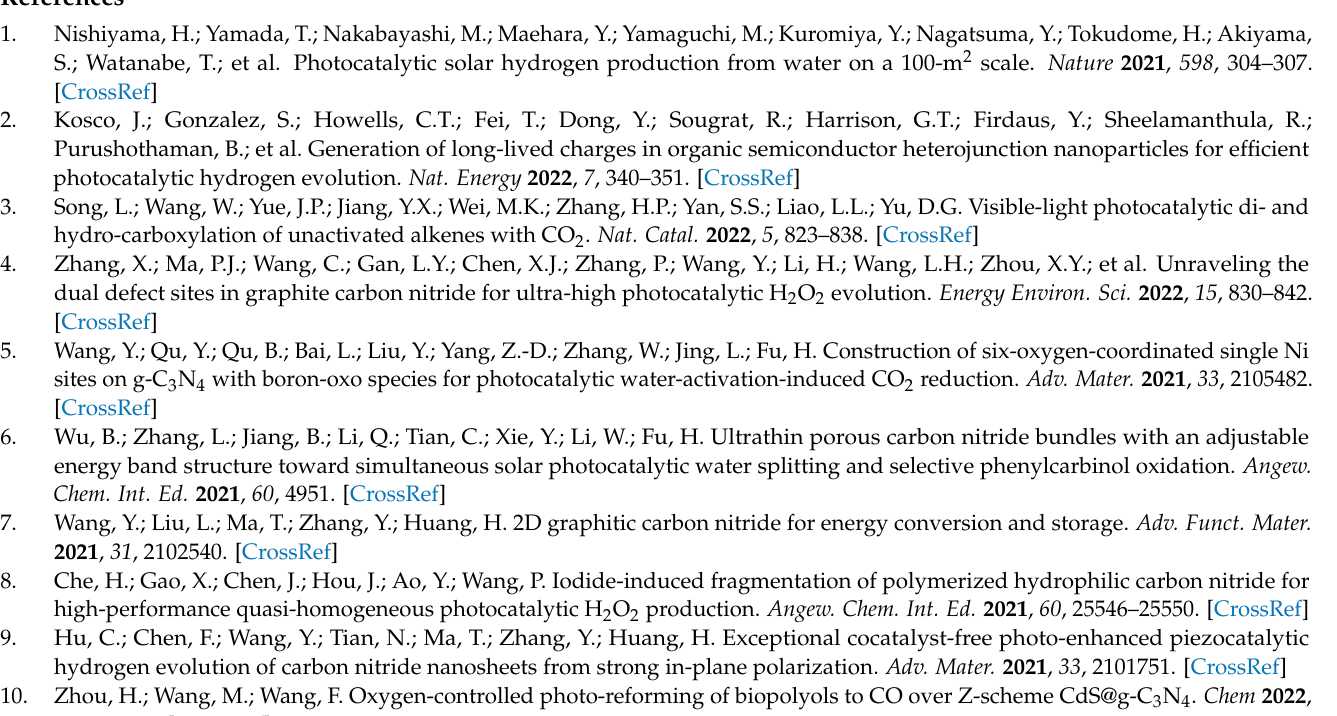
Figure S5: Degradation of TC by catalysts with different Ag loadings. Figure S6: IR images of the pure water under illumination with a 300 w xenon lamp as a function of time. Figure S7: Photocatalytic degradation of other pollutants by Ag/ α -Fe 2 O 3 /g-C 3 N 4 . Table S1: Comparison of the performance of Ag/ α -Fe 2 O 3 /g-C 3 N 4 and other similar photocatalysts for H 2 evolution.; Table S2: